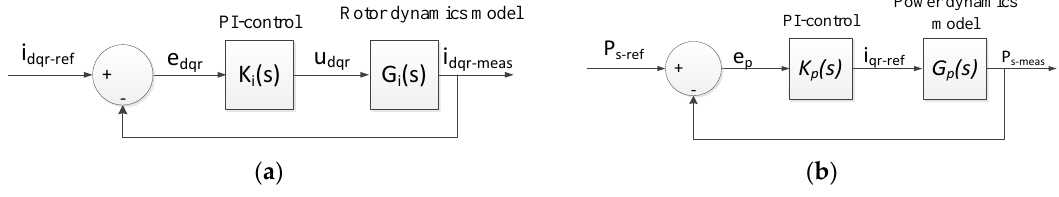
Figure 5. The PI control structure of the NPC-VSCr: ( a ) the current controller (inner loop); ( b ) the active power control (outer loop).